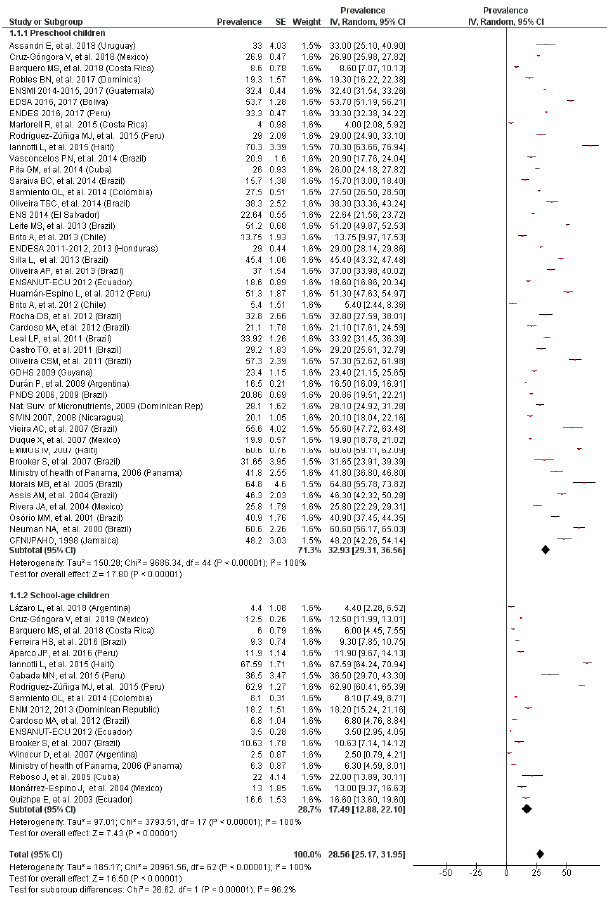
Figure 2. Prevalence of anemia by age.